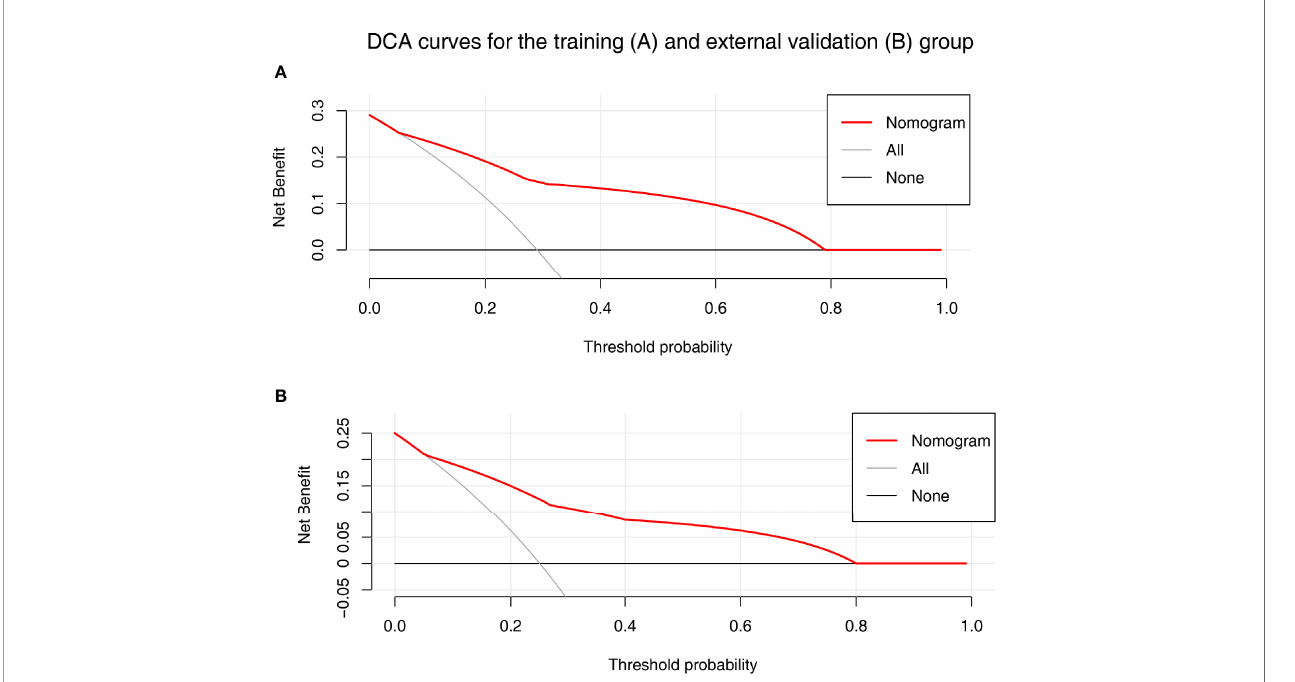
FIGURE 5 | The decision curve analysis (DCA) for the nomogram in training (A) and validation (B) set. Nomogram contains both baseline LS of tumorous foci and ALBI grade were shown in red. Result showed that using the nomogram for PD prediction has more bene fi t than the treat-all-patients scheme (gray curve). A larger area under the decision curve suggested a better clinical